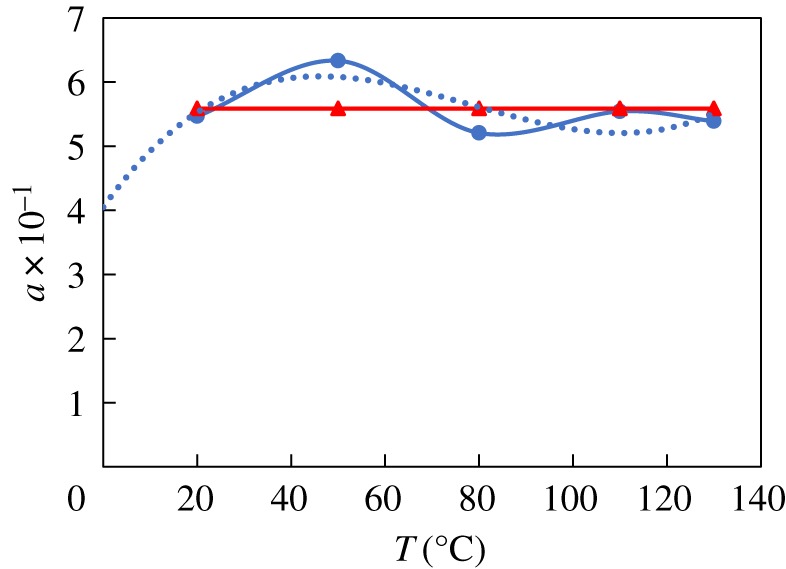
Fitting of constant a1 and temperature.